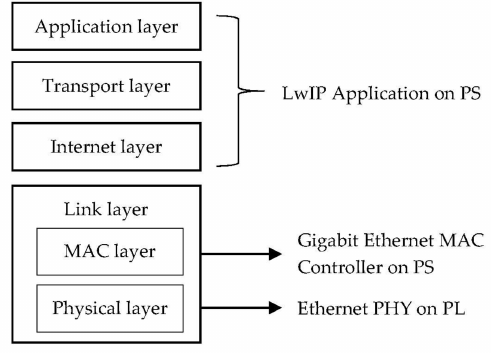
Figure 6. The design of the TCP / IP model on a ZedBoard.